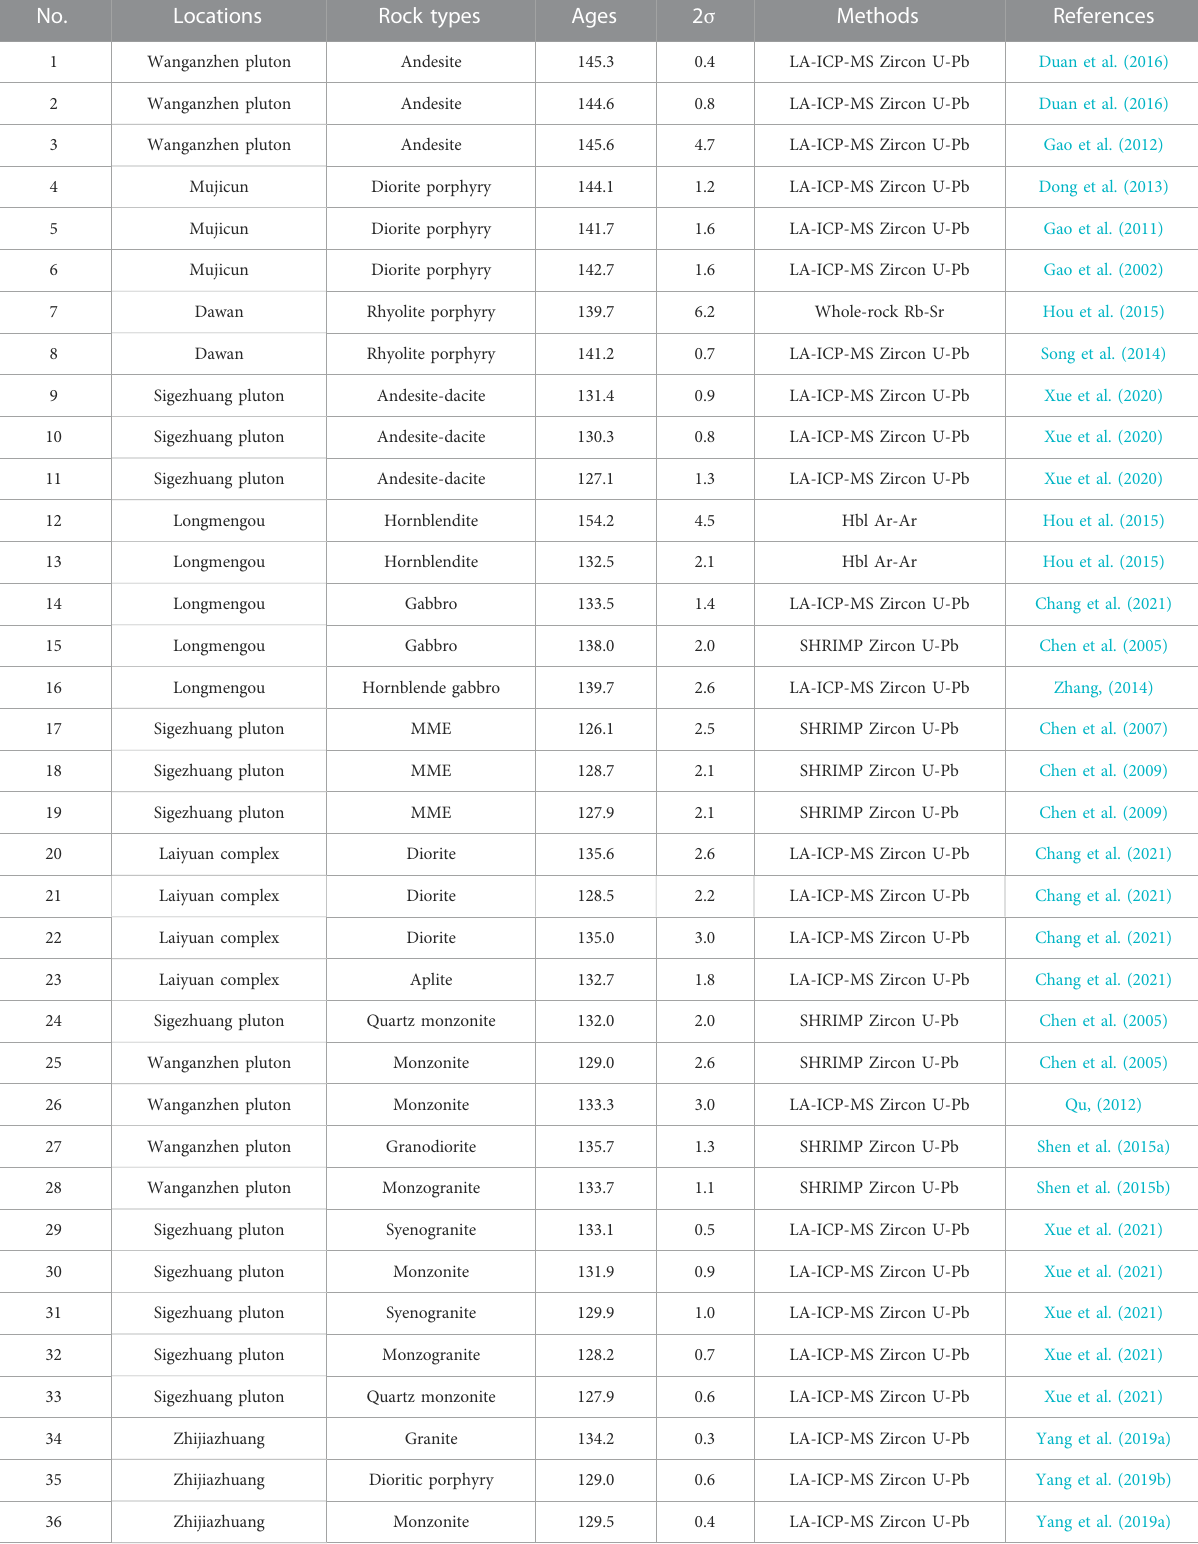
TABLE 1 Compilation of age data of the Laiyuan magmatic rocks.